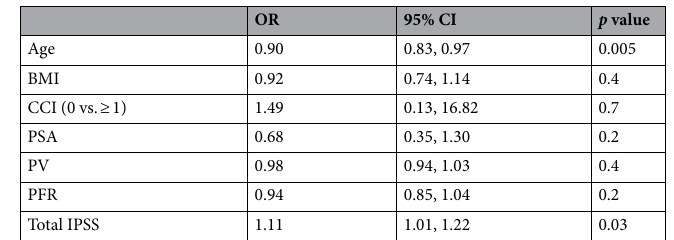
Table 4. Logistic regression analysis testing predictors of PBNO among patients with urethrocystoscopy (N = 879 (72%)). Keys: PBNO = primary bladder neck obstruction; BMI = body mass index; CCI = Charlson comorbidity index; PSA = prostate-specific antigen; PV = prostate volume; PFR = peak flow rate; IPSS = International Prostate Symptoms